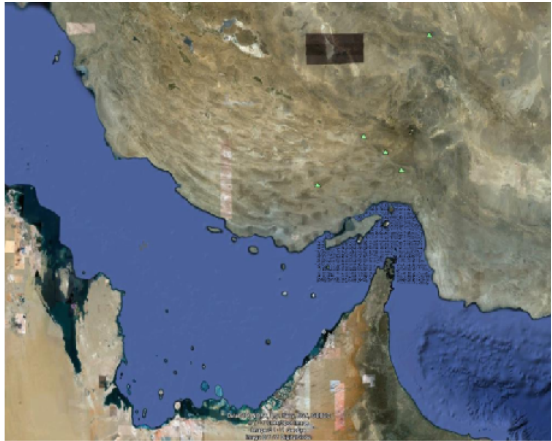
Figure 4. Surface current vector field Over the Coastal area of Hormuz Strait in an overall view and low resolution but high density.